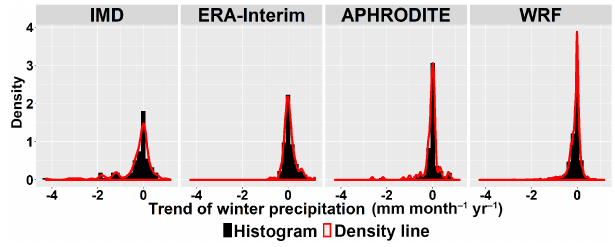
Figure 10. Density curves of trends (mmmonth − 1 year − 1 ) of win- ter precipitation in all grid points.